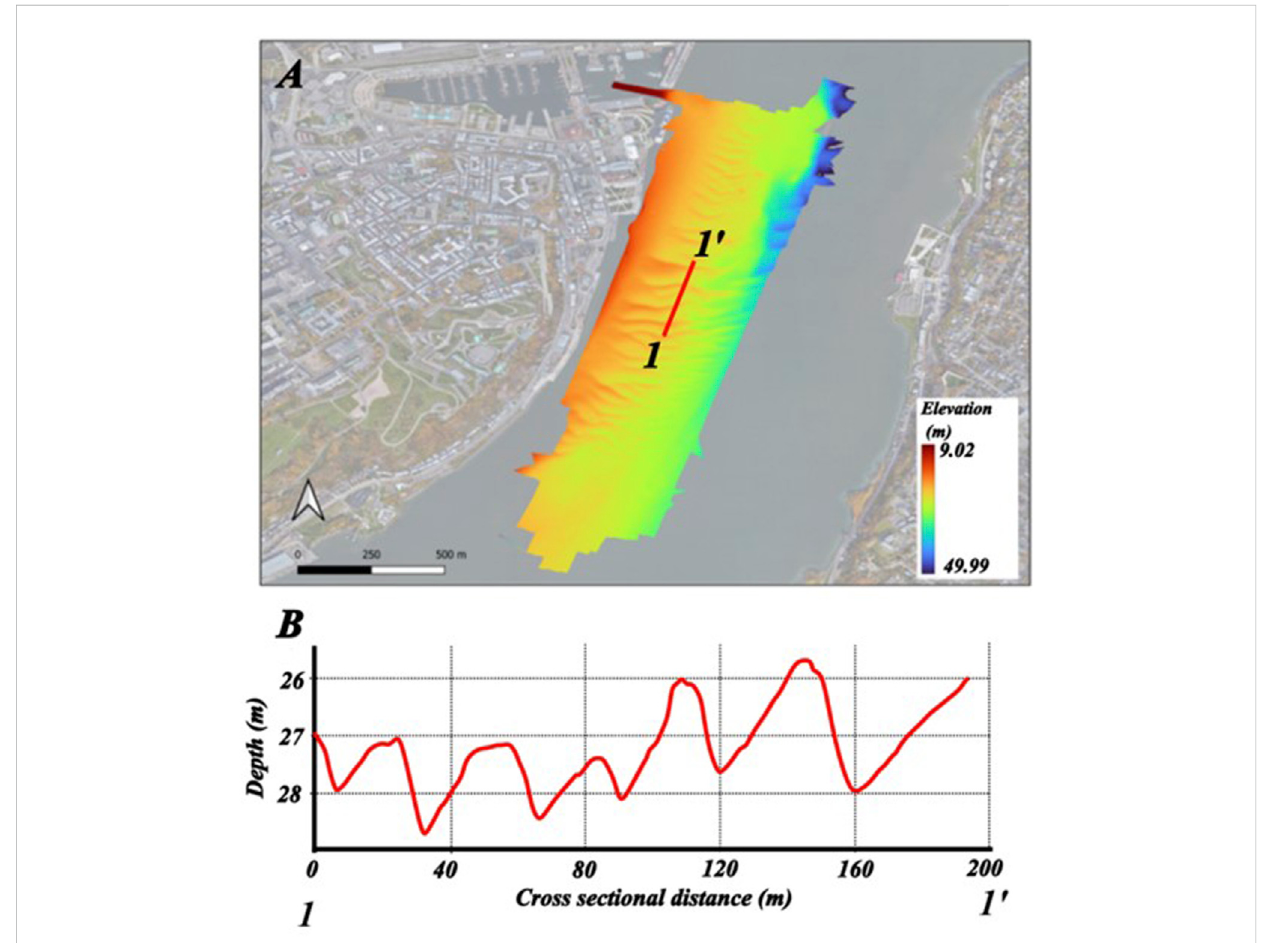
FIGURE 8 Combined multisource DBM generated with our proposed approach considering the four datasets [cf. ( Panel A) ] and cross section pro fi le through the fi eld of dunes [cf. ( Panel B) ].